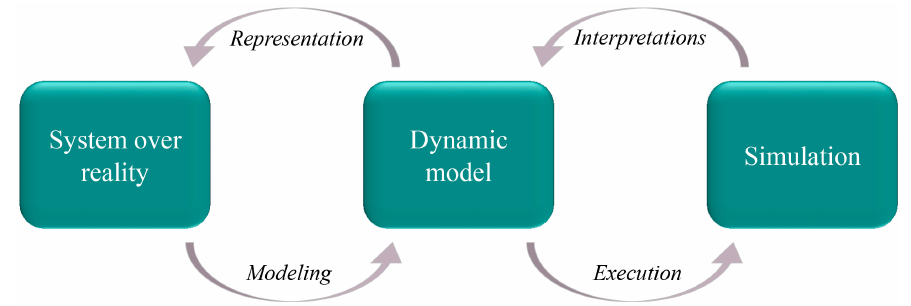
Figure 2. Representation of MABS steps adapted from